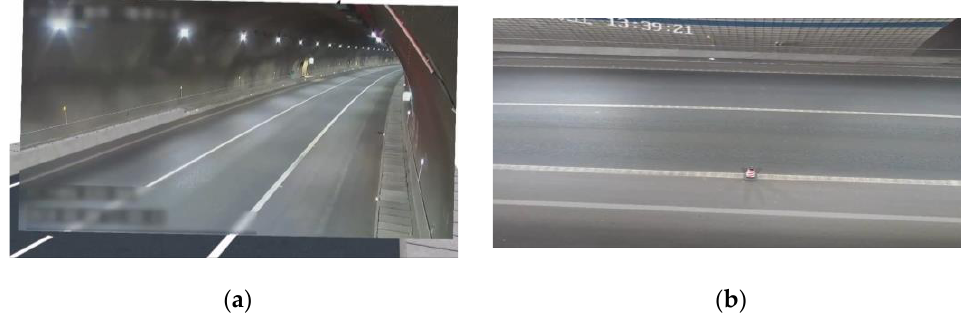
Figure 6. Example of lightweight processing and results of the tunnel model: ( a ) Example of gun machine fusion; ( b ) Example of fisheye camera fusion.